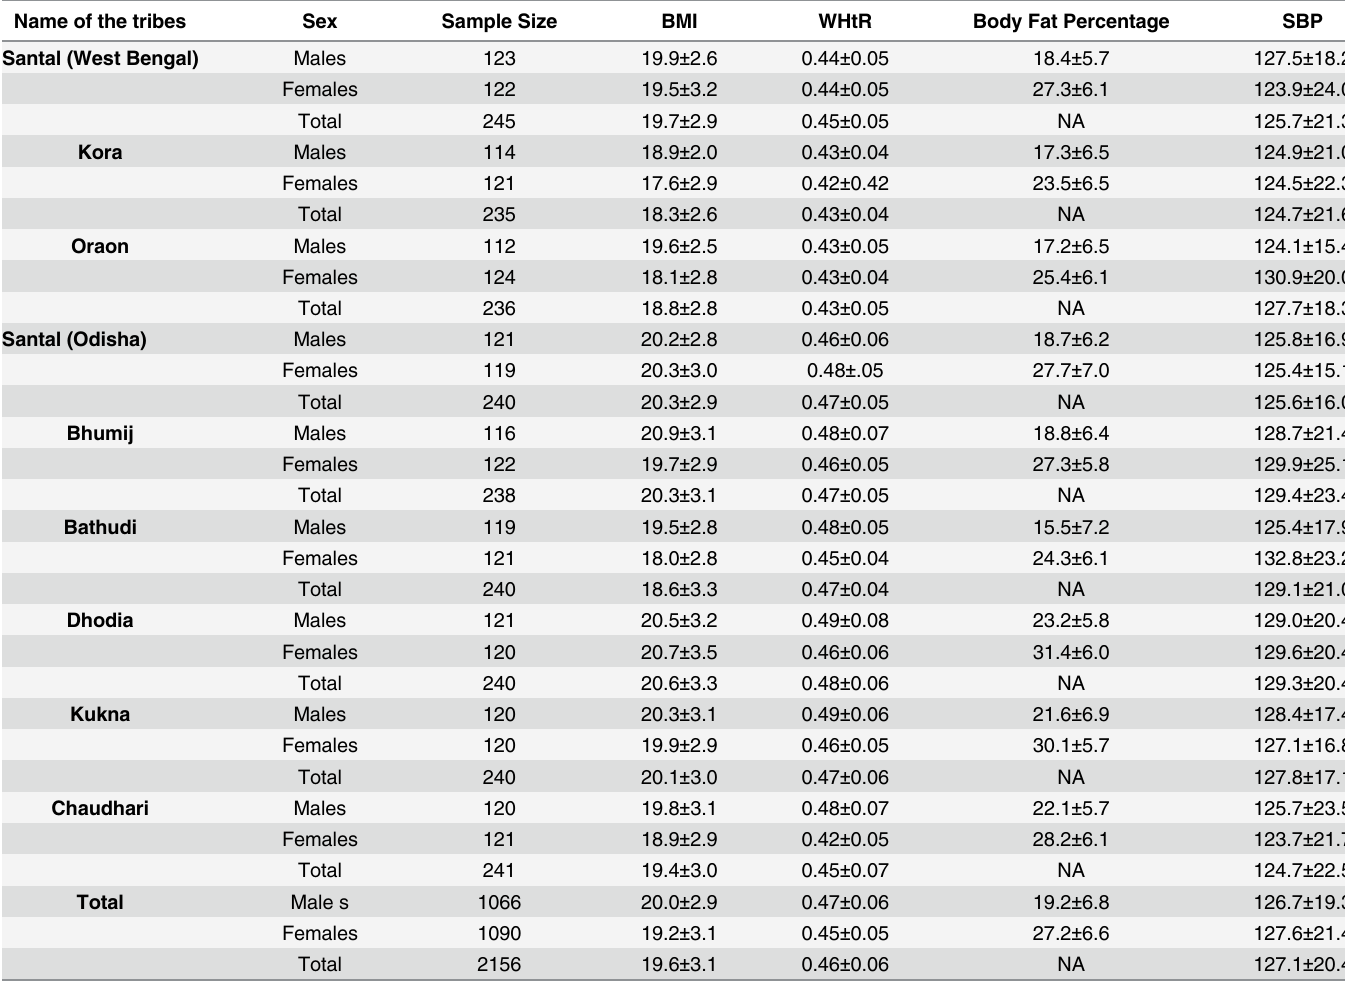
Table 1. Demographics and population characteristics of selected